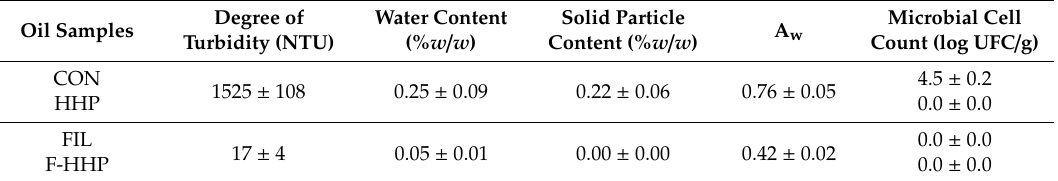
Table 1. Mean values and standard deviations of the turbidity characterization parameters for the four specimens of just processed olive oil samples; CON = veiled and not HHP-treated oil samples; HHP = veiled and HHP-treated oil samples; FIL = filtered and not HHP-treated oil samples; F-HHP = filtered and HHP-treated oil samples. Number of replicates =